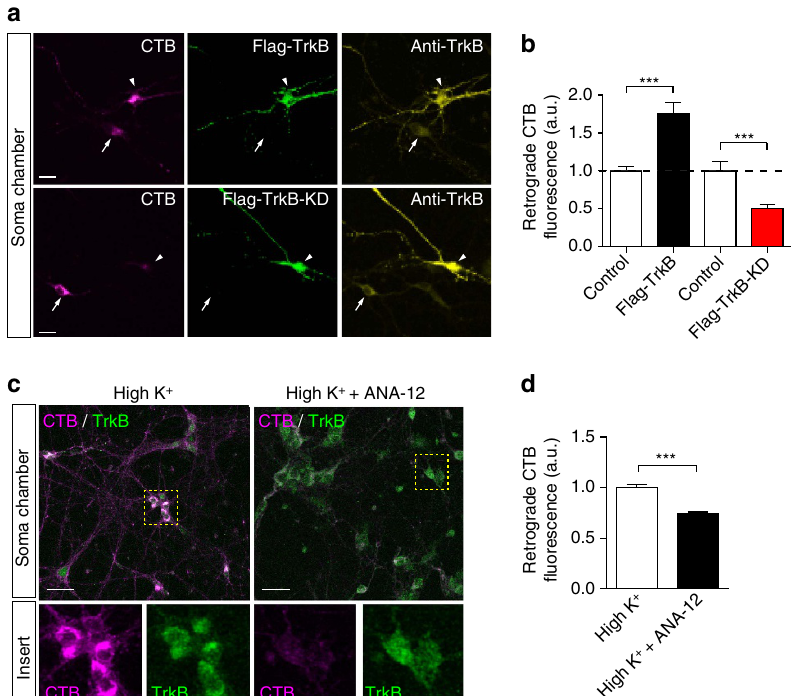
Figure 8 | Genetic inhibition of TrkB activation prevents the activity-dependent retrograde transport of CTB. ( a ) DIV14–16 hippocampal neurons cultured in microfluidic chambers were transfected with Flag-TrkB-WTor Flag-TrkB-KD plasmids, and subsequently labelled with CTB under pulse-chased high K þ . The fluorescence intensity of retrogradely transported CTB was observed with confocal microscopy in transfected neurons (arrow) and adjacent untransfected neurons (arrowheads) in the soma chambers only. Scale bar, 20 m m. ( b ) Quantification of a (mean ± s.e.m., n ¼ 26, 46, 34 and 42 for the control, Flag-TrkB, control and Flag-TrkB-KD groups respectively, data from three independent cultures, *** P o 0.001, Student’s t -test). ( c ) Neurons cultured in microfluidic chambers were labelled with CTB under high K þ pulse, then pretreated with 0.5 m M ANA-12 for 30min. The fluorescence intensity of retrogradely transported CTB and endogenous TrkB were observed with confocal microscopy in the soma chambers. Scale bar, 50 m m. ( d ) Quantification of ( c ). (mean ± s.e.m., n ¼ 15 and 17 for low K þ and high K þ groups, respectively, data from three independent cultures, *** P o 0.001, Student’s t